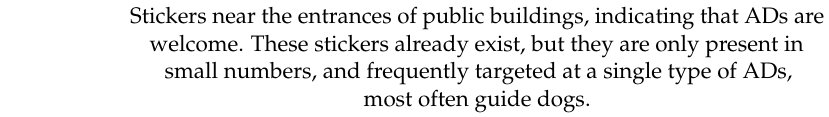
Identification and welcoming of